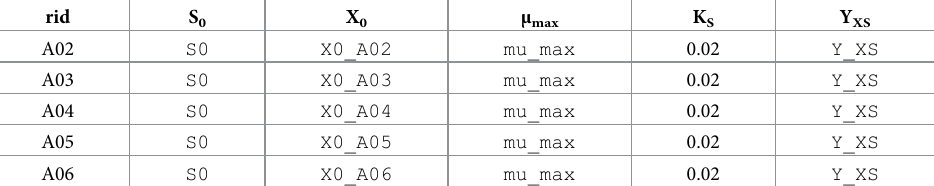
Table 1. Tabular representation of a parameter mapping. With columns corresponding to the parameter names of a naive Monod process model, the parametrization of each replicate, identified by a replicate ID (rid) is specified in a tab- ular format. Parameter identifiers that appear multiple times (e.g. S0) correspond to a parameter shared across repli- cates. Accordingly, replicate-local parameters names simply do not appear multiple times (e.g. X0_A06). Numeric entries are interpreted as fixed values and will be left out of parameter estimation. Columns do not need to be homo- geneously fixed/shared/local, but parameters can only be shared within the same column. The parameter mapping can be provided as a DataFrame